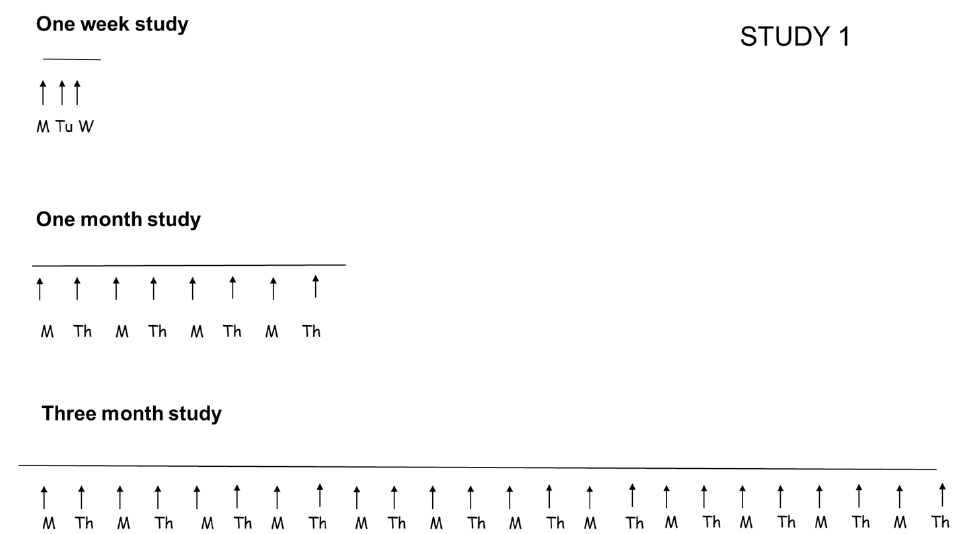
Figure 1. Protocol of allergen challenges in Study 1 aimed to assess the effect of duration of allergen exposure. The same allergen dose was used for each dog (25mg of house dust mite) in the three protocols, but different duration and number of challenges was done in the three studies. In the one week study, the dogs were challenged Monday, Tuesday and Wednesday (M, Tu, W). In the one month and the three-month studies, the dogs were challenge Monday and Thursday (M, Th) of each week .